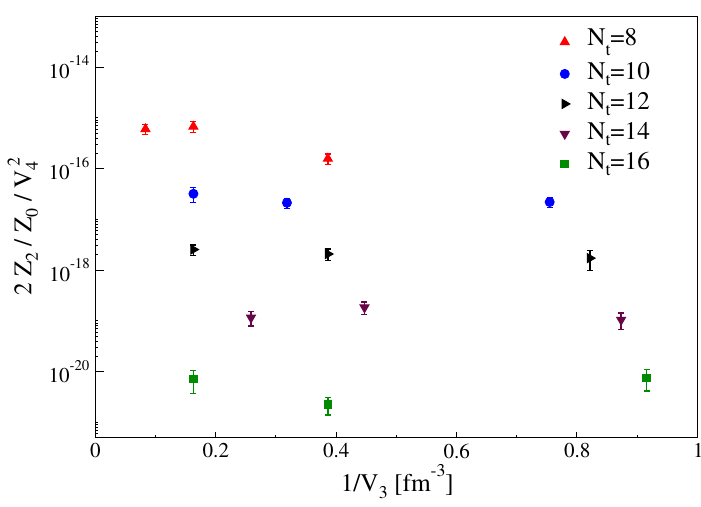
Figure 10 . Ratios of the partition functions with j Q j = 2 to that with j Q j = 0, divided by V 2 the same lattice spacings and volumes shown in (cid:12)gure